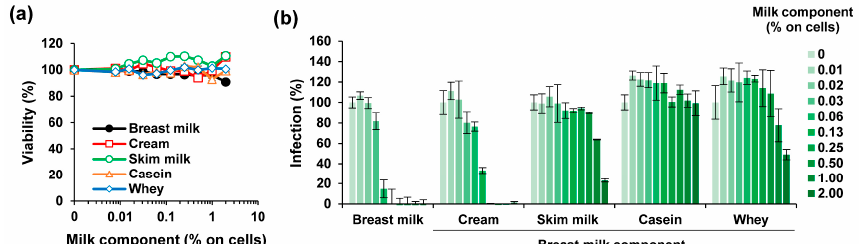
Figure 3. Effect of fractions derived from long-term freeze-stored breast milk on ZIKV infection. ( a ) Pooled long-term stored breast milk was defatted by centrifugation, the cream collected and resuspended in PBS at the original volume. The remaining skim milk was further ultracentrifuged to separate caseins from serum proteins. The casein-containing pellet was resuspended in PBS to the original volume and the supernatant (whey) collected. The breast milk and its components were then incubated on Vero E6 cells at indicated concentrations for 2 h. The medium was then replaced, and the cellular viability was determined 2 days later by CellTiter-Glo Assay. ( b ) Breast milk and its components were mixed 1:1 with ZIKV MR766 (1.58 × 10 7 TCID 50 / mL) for 10 min before 10-fold dilution onto Vero E6 cells resulting in indicated concentrations. Then, 2 h after inoculation, the medium was changed and, 2 days later, the infection rates were determined by a cell-based immunodetection assay that enzymatically quantifies the flavivirus protein E. All data are normalized to values in the absence of the respective sample. Data are represented as average values obtained from triplicate infections ± standard deviations.